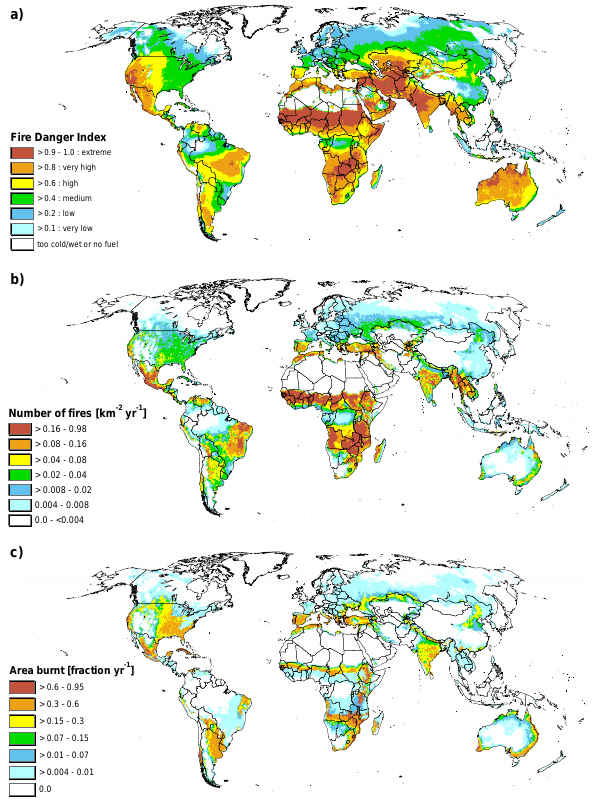
Fig. 3. Simulation results: (a) fire danger index, (b) number of fires, (c) fractional area burnt (all as annual averages for 1982–1999).